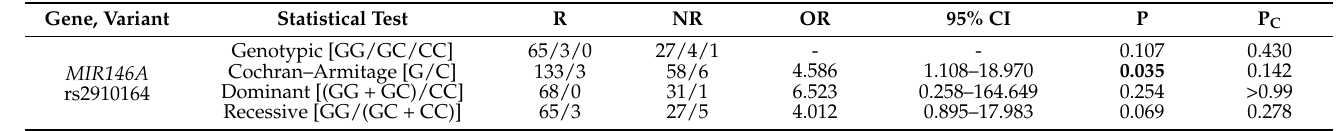
Table 4. Association between the studied genetic variants and response to anti-TNF therapy in the PsO